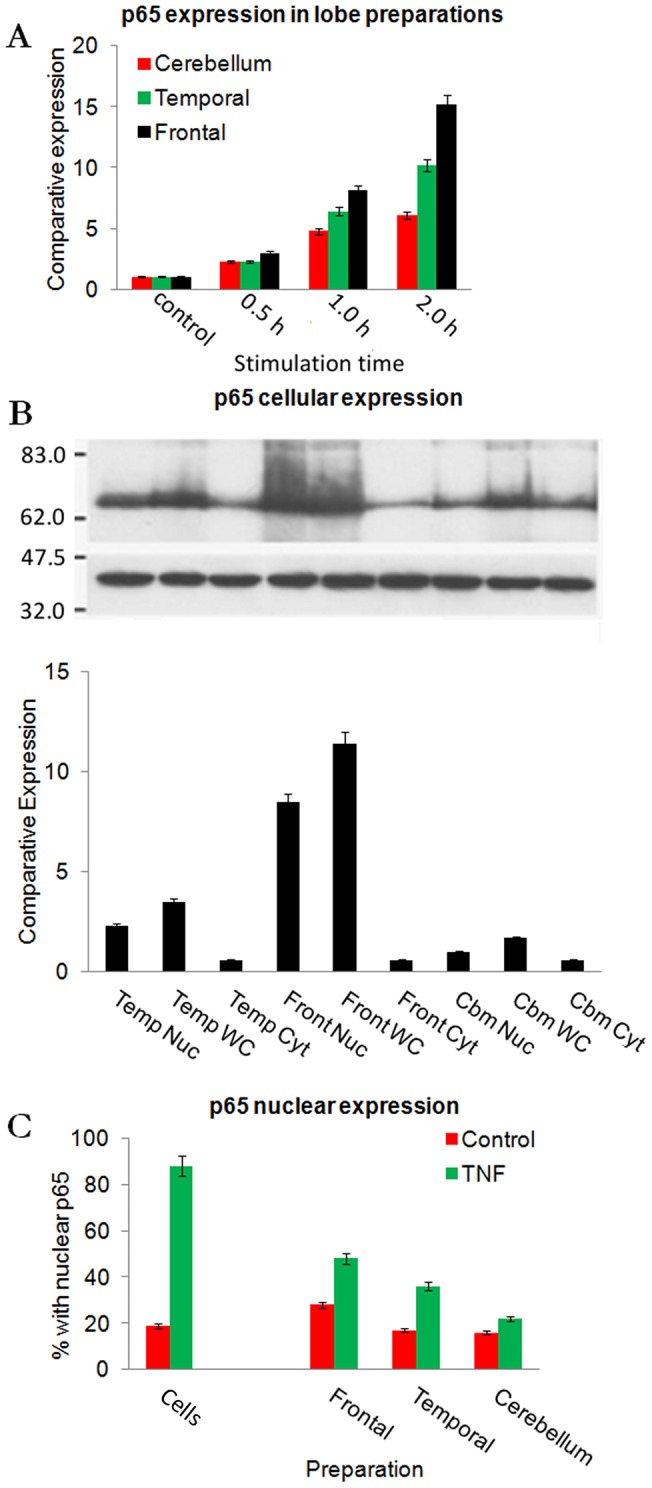
Western Blot analysis of p65 subunit of NF-κB.A: NF-κB p65 expression after stimulation with TNF-α for 0, 0.5, 1 and 2 hours. Frontal lobe (Front), Temporal region (Temp) and Cerebellum were examined (F = 8.57; p = 0.012; df = 2,57). B: Western Blot analysis of p65 subunit of NF-κB nuclear vs. cytoplasmic analysis after 1 hour of TNF-α stimulation, comparing whole cell expression (WC) to nucleus (Nuc) and cytoplasmic (Cyt) preparations, data is significant after 1 hour of stimulation (F = 5.56; p = 0.043; df = 2,27). Calibration bars are 10 µm. C: The percentage of neurons with anti-p65 staining in the nucleus, comparing in vivo frontal lobe, temporal region and cerebellum neurons with the aggregate of all cells (F = 20.99; p<0.001; df = 3,36). Molecular weight markers are in kilodaltons (kDa).